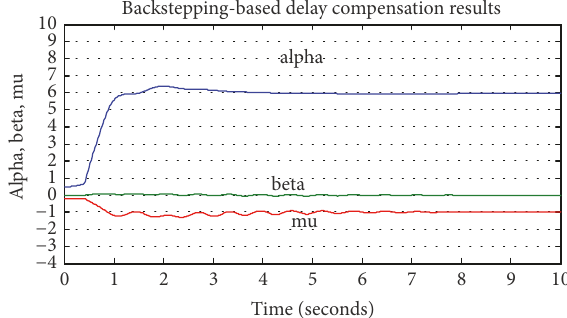
Figure 1: Uncompensated tracking results.